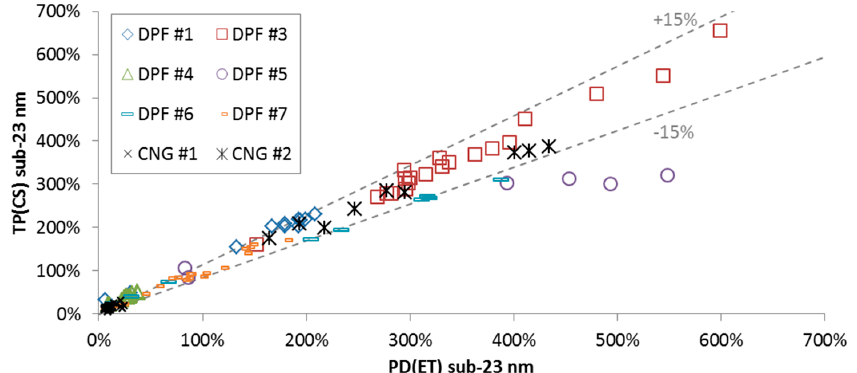
Figure 6. Sub-23 nm percentages determined with the “Golden” system with catalytic stripper at the tailpipe TP(CS) and the PMP system with evaporation tube at the proportional partial flow system PD(ET) for various tests and engines.